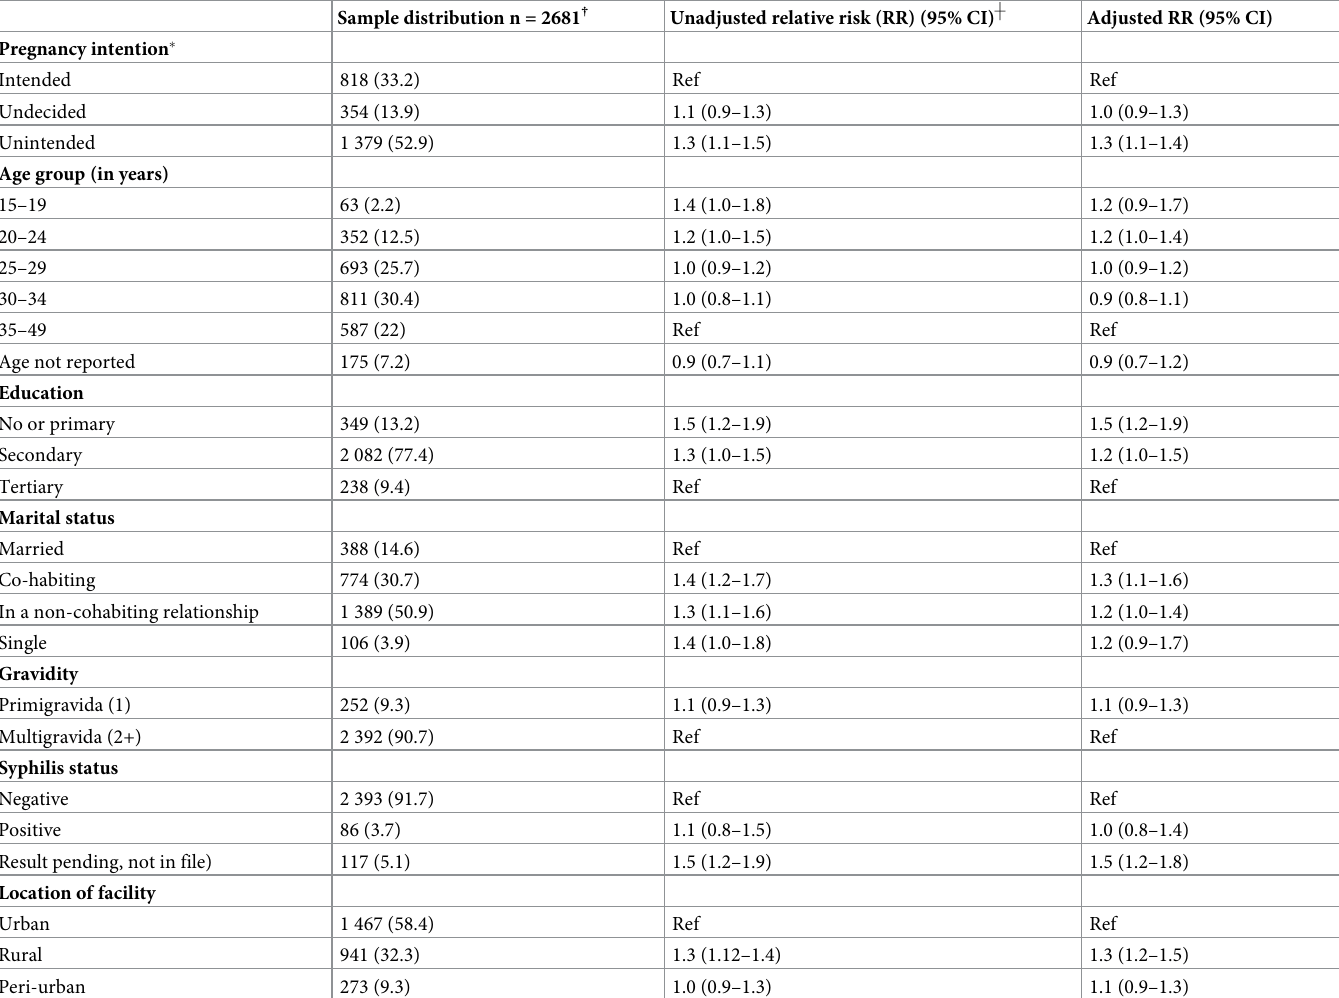
Table 3. Association between unsuppressed viral load during the third trimester of pregnancy and unintended pregnancy among women who initiated ART before pregnancy in the 2019 antenatal